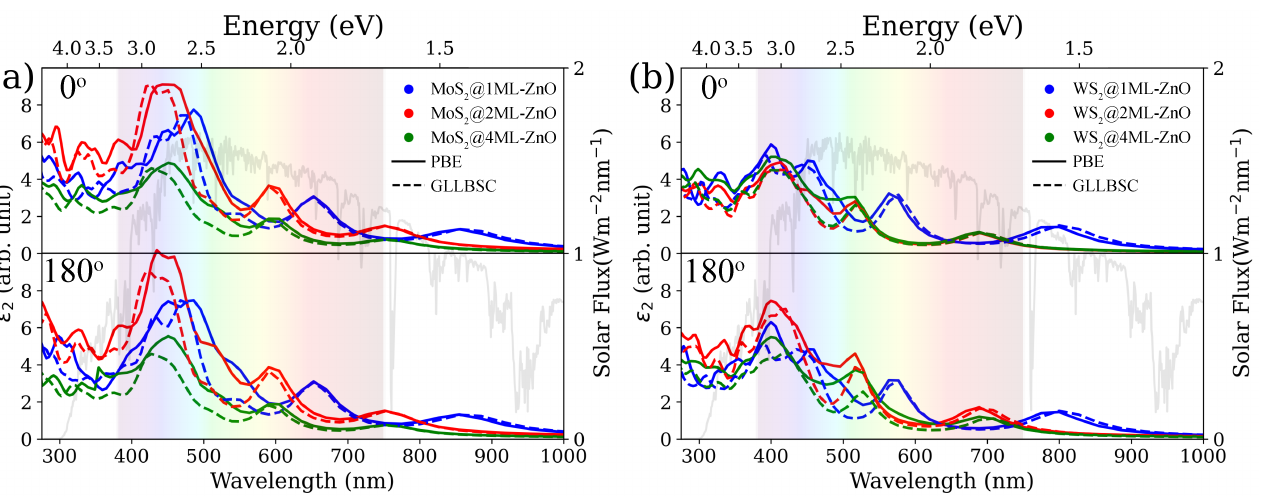
Figure 8. Imaginary part of dielectric function ( ε 2 ) of the MoS 2 @ZnO ( a ) and WS 2 @ZnO ( b ) 2D nanocomposites. The upper and lower panels are for the MoS 2 and WS 2 with the rotation angle of 0 ◦ and 180 ◦ , respectively. The right y-axis stands for the solar spectrum based on AM 1.5 [71] (gray